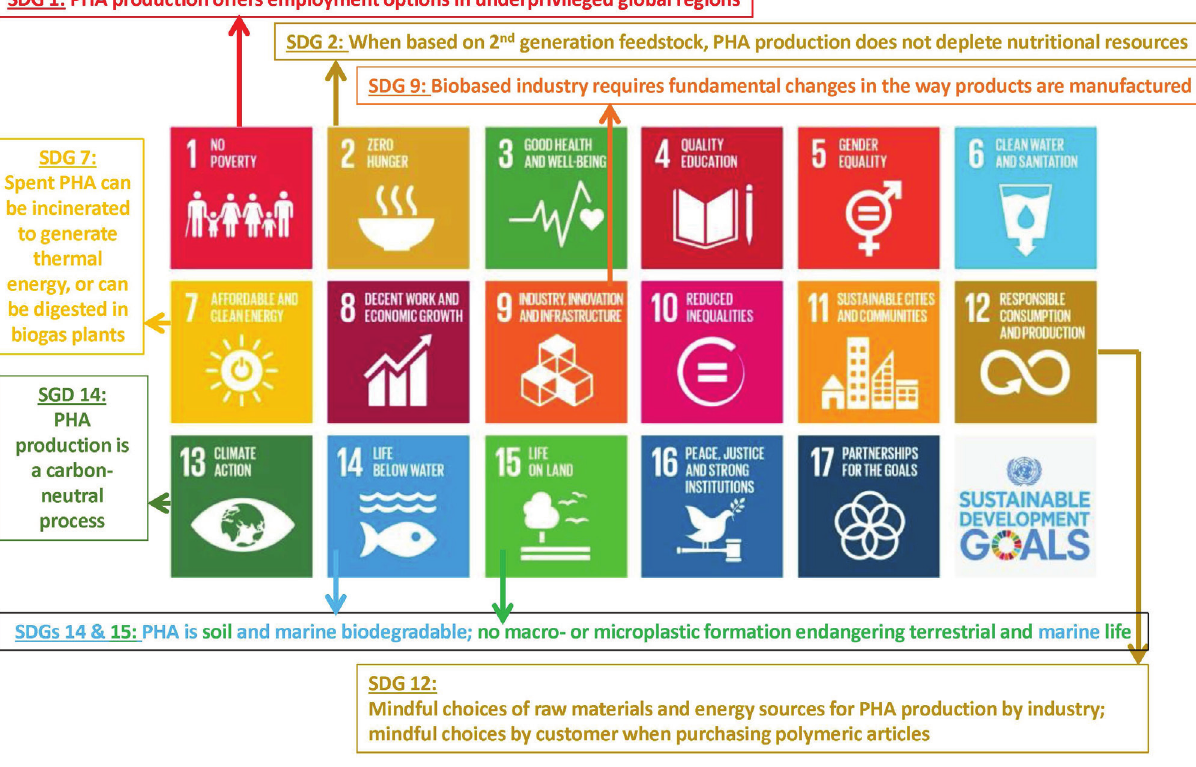
Fig. 3 – The 17 UN Goals for Sustainable Development and their relation to PHA